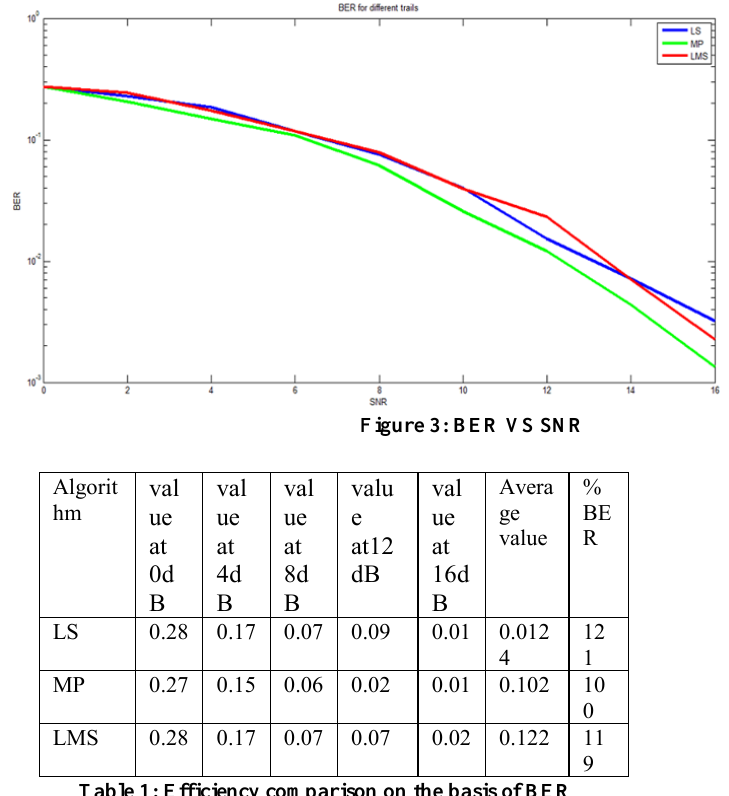
Table 1: Efficiency comparison on the basis of BER